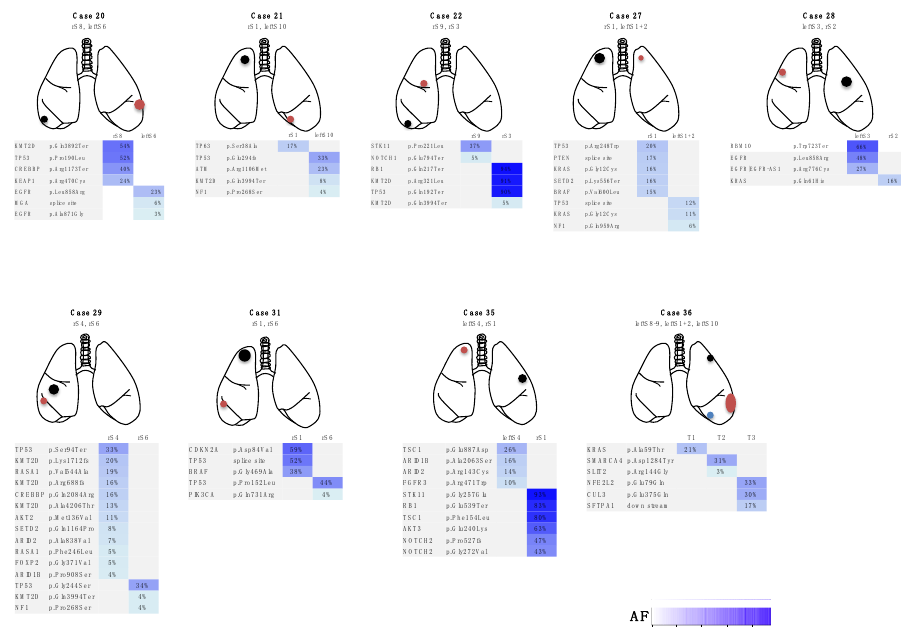
Figure 1. Heatmap of gene mutations in patients with double or triple primary lung cancers. These maps visualize the gene mutations in each cancer. Two or three lung cancers in each patient were characterized by different mutation profiles and all patients were diagnosed with double or triple primary lung cancers. Case 21, 22 and 28 were metachronous cancers, while the other cases in this figure were synchronous cancers. The remaining 5 cases of double primary lung cancers (cases 12, 18, 24, 26 and 34 in Tables 1 and S2) that are not shown in this figure are described in detail in the Case presentation section. Black, red and blue indicate tumor 1 (T1), T2 and T3, respectively. r, right; S, segment; AF, allele fraction; MIA, microinvasive adenocarcinoma; AIS, adenocarcinoma in situ.